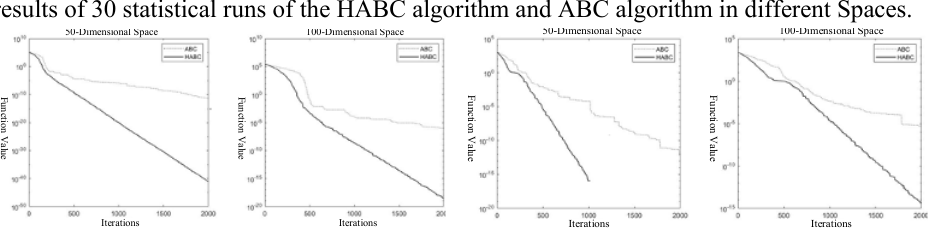
Fig. 2. The convergence curves of Step in 50- dimensional space and 100-dimensional space.